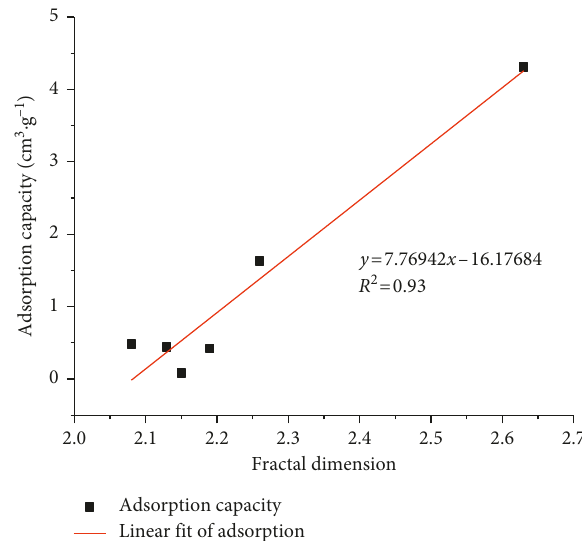
Figure 14: Relationship between adsorption quantity and pore surface fractal